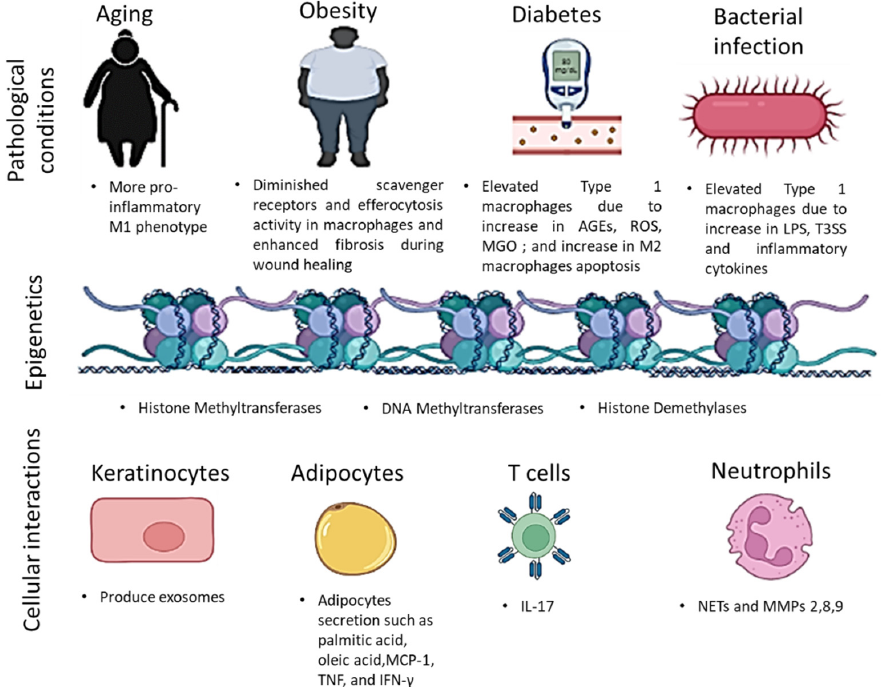
Figure 2. Different diseases and pathological conditions such as diabetes and obesity, epigenetic elements, and different cellular activities can induce inflammation by affecting macrophages functions which promote M1 macrophages activities.